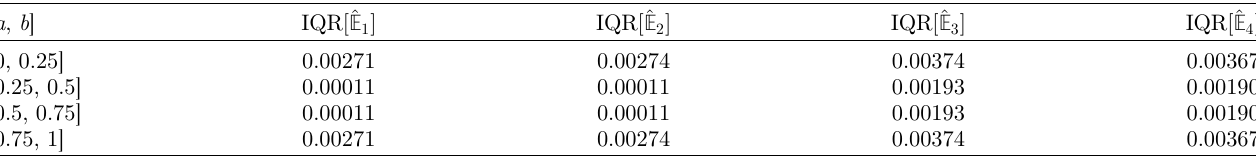
Table 4. Interquartile ranges (IQR) evaluated on Gaussian copula, i = 1, 3 from Informative settings, i = 2, 4 from Non Informative settings, according to Table